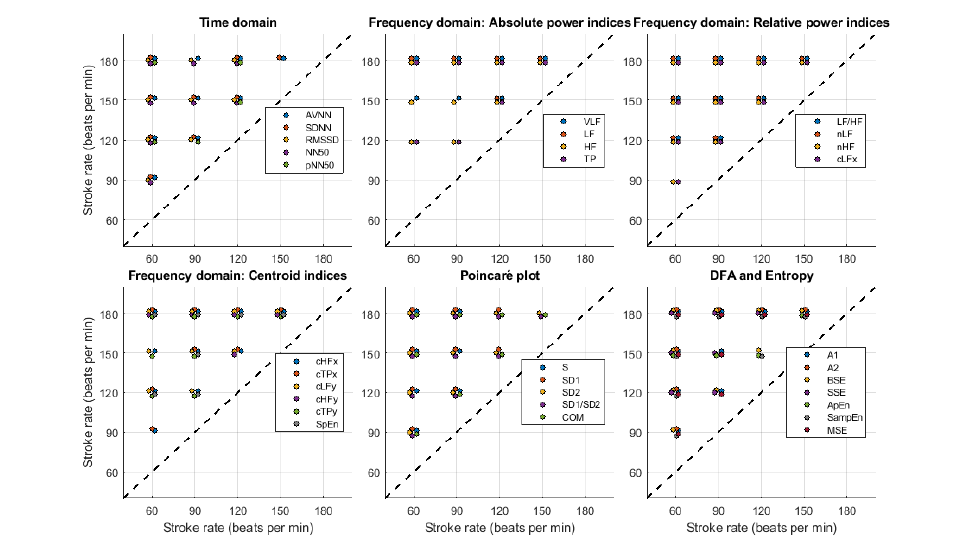
Figure 12. Post-hoc comparisons for stroke rate (SR) levels when pulse rate variability indices are measured from the deep palmar arch phantom. The appearance of a circle indicates a significant difference between the corresponding levels for each of the